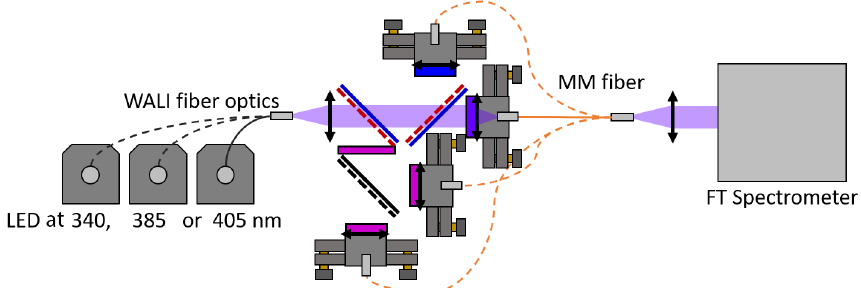
Figure 7. Method for polychromator alignment validation. Light from LEDs is input in the WALI fiber optics and passes through the polychromator and into a multi-mode fiber (MM fiber, Ø600µm) analyzed by a Thorlabs OSA201C Fourier transform spectrometer. Central channel wavelengths are expected not deviate from those of the filter measured independently at normal incidence, to validate alignment.